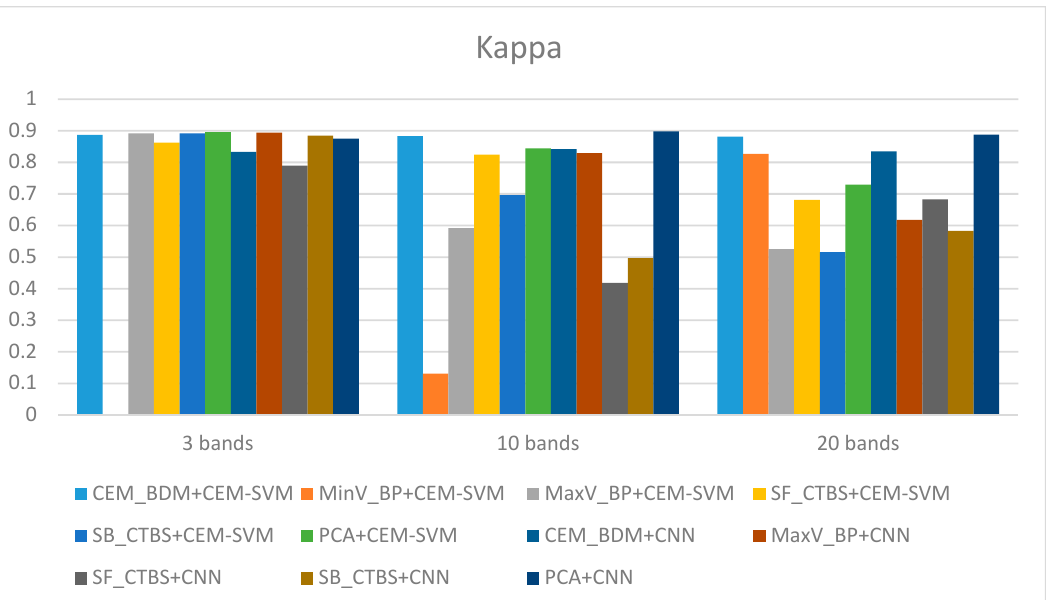
Figure 49. The ACC accuracy histograms of 3 bands, 10 bands, and 20 bands.